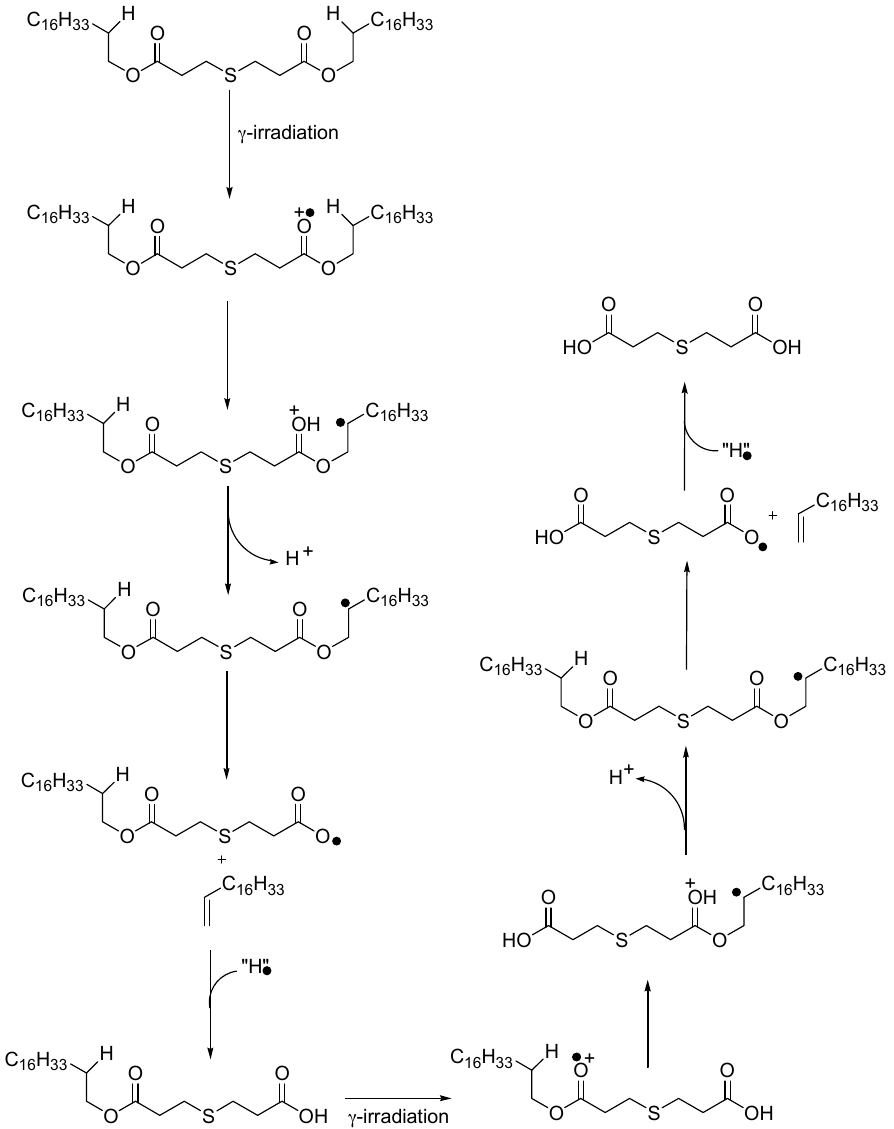
Figure 7. Proposed pathway for the degradation of Irganox PS802 into 3,3 ′ -thiodipropionic acid.